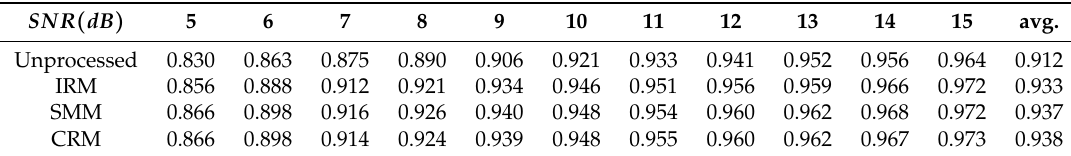
Table 1. Effect of echo attenuation on STOI.